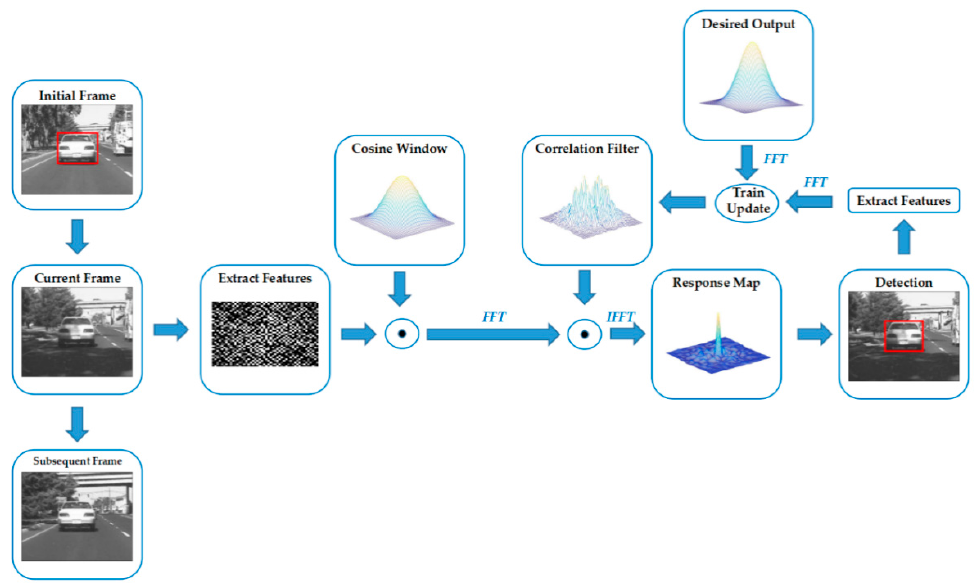
Figure 1. Illustration of the standard DCF framework. Firstly, the correlation filter is trained by the first frame with an initial bounding box and the desired output. Secondly, it extracts the features from the current frame and multiplies a cosine window to emphasis on the center region. The features are then transformed into the frequency domain by utilizing the fast Fourier transformation (FFT). Thirdly, the response map is obtained by multiplying the correlation filter and the extracted features. The response map is transformed into the time domain by applying the inverse fast Fourier transformation (IFFT). Finally, the position of the maximum value of the response map is regarded as the center position of the target in the current frame. The new features are then extracted from the detected result to train and update the correlation filter.